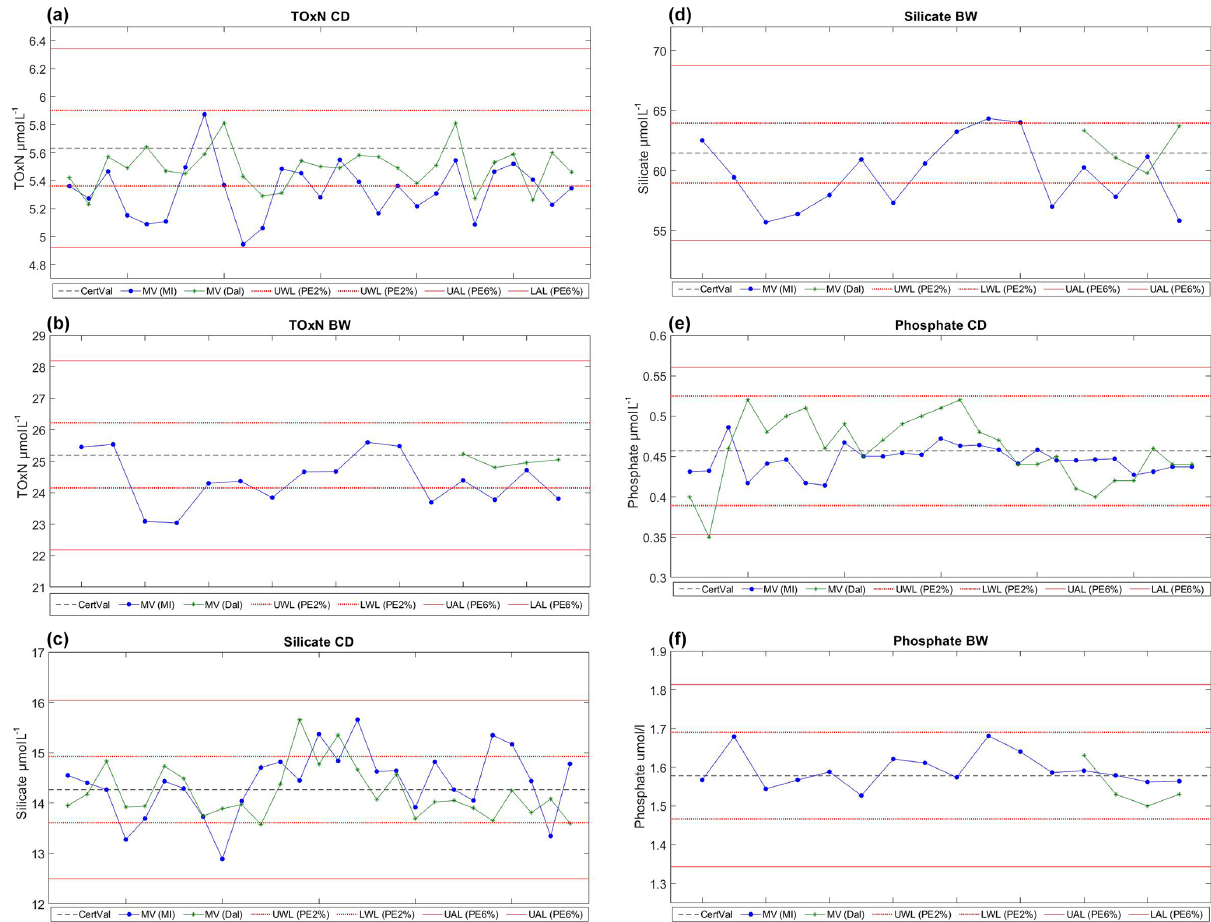
Figure 4. Control charts of CRM concentrations from the MI and Dal systems. The dashed centre line represents the certified value for each CRM (CV), while the red upper (UAL, upper action limit) and lower (LAL, lower action limit) lines represent the z score of two allowable limits criteria, where the z scores were calculated with a proportional error of 6%. MV (MI) and MV (Dal) are the measured values from the MI and Dal systems, respectively. The dashed–dotted and dotted lines represent the revised z -score limits with a proportional error of 2%. One CD CRM was run at the beginning and end of every run on both systems, and one BW CRM was analysed at the beginning of every run on the MI system. BW CRMs were run on only a selected number of runs of the Dal system for